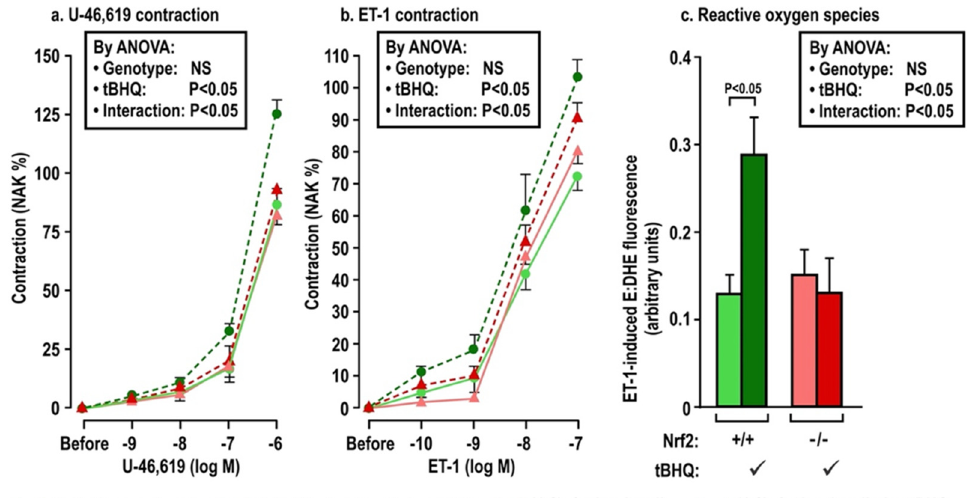
Figure 3. Oral tBHQ given to mice during a three-day infusion of angiotensin II enhances the contractions to thromboxane (Panel a ) and endothelin I (Panel b ) and the reactive oxygen species generation with endothelin 1 (Panel c ) in mesenteric microartioles from Nrf2 +/+ mice, but fails to enhance these in arterioles from Nrf2 − / − mice. Mean ± SEM values (n = 6 per group) in mesenteric microarterioles from Nrf2 wild type (+/+) or knockout ( − / − ) mice of group 2 given tBHQ (0.1% × 3 days) vs. vehicle. These mice were all infused with angiotensin II (400 ng·kg − 1 ·d − 1 SC × 3 days). Nrf2, nuclear factor erythroid factor E2-related factor 2. See legend to Figure 2.